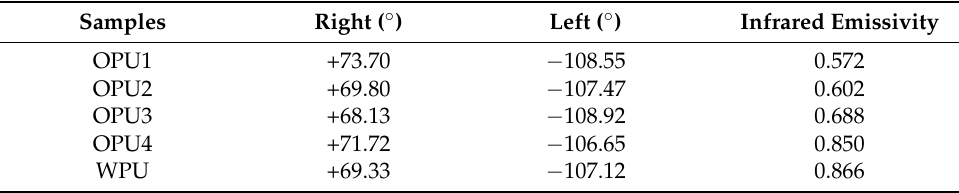
Table 2. Optical rotation of WPU and